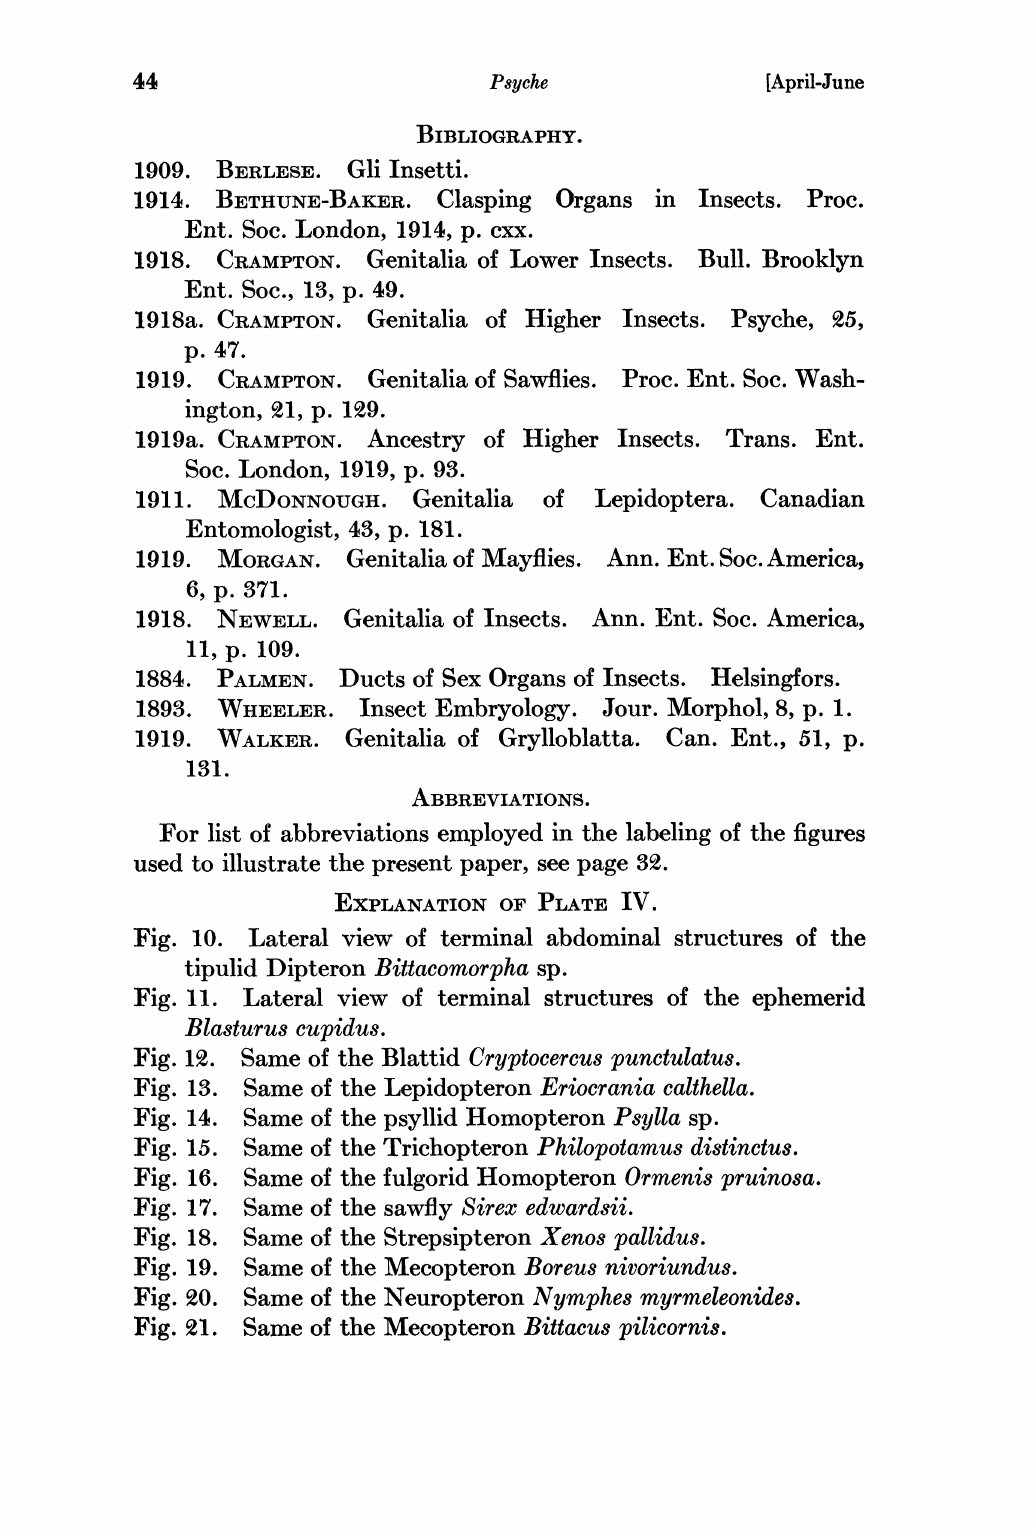
Fig. 10. Lateral view of terminal abdominal structures of the tipulid Dipteron Bittacomorpha sp. Fig. 11. Lateral view of terminal structures of the ephemerid Blasturus cupidus. Same of the Blattid Cryptocercus punctulatus. Fig. 13. Same of the Lepidopteron Eriocrania calthella. Fig. lS. Same of the psyllid I-Iomopteron Psylla sp. Fig. 14. Same of the Trichopteron Philopotamus distinctus. Fig. 15. Same of the fulgorid }tomopteron Ormenis pruinosa. Fig. 16. Same of the sawfly Sirex edwardsii. Fig. 17. Same of the Strepsipteron Xenos pallidus. Fig. 18. Same of the Mecopteron Boreus nivoriundus. Fig. 19. Same of the Neuropteron Nymphes myrmeleonides. Fig. Same of the Mecopteron Bittacus Fig. 31.